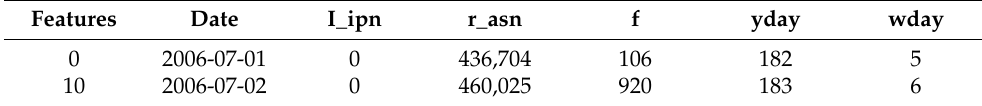
Table 1. Dataset after grouped by daywise flux.